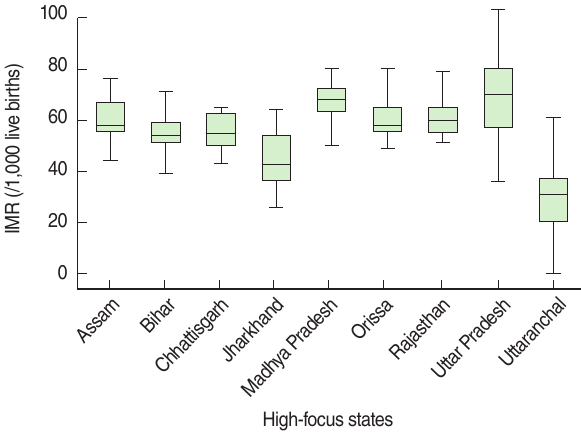
Figure 1. Range and quartile for infant mortality rate (IMR) for high- focus status of India (2010-2011).